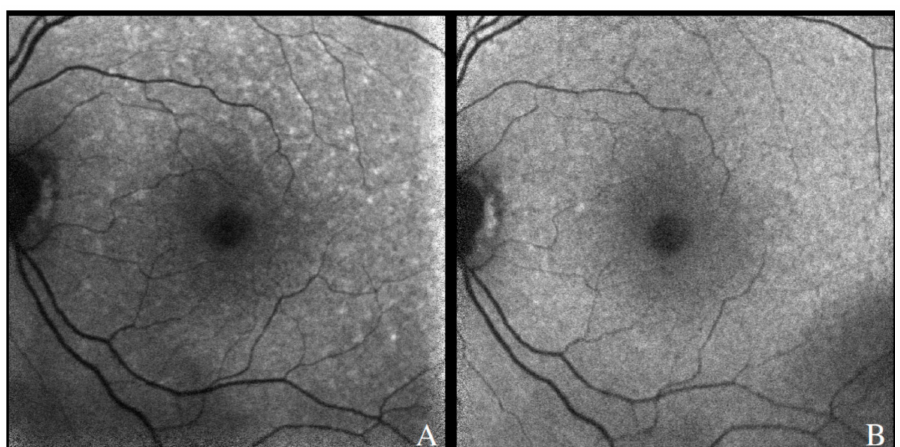
Figure 8. Fundus autofluorescence demonstrating hyperautofluorescent spots in the posterior pole of a patient with recurrence of PVRL ( A ). There was resolution after therapy involving systemic chemotherapy, with few residual hypoautofluorescent spots along the superior arcade ( B ).